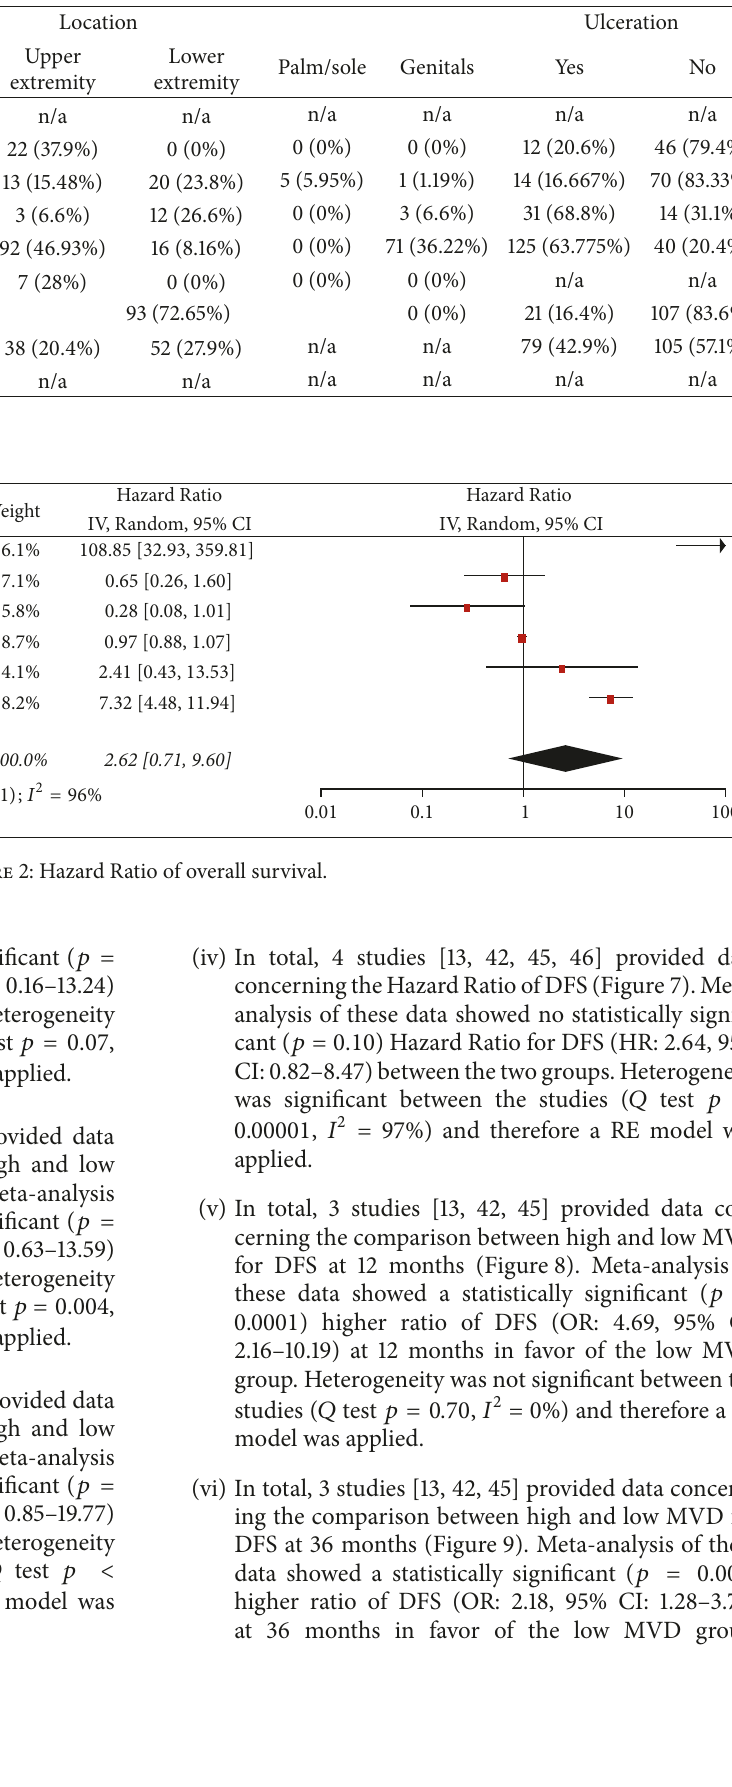
Table 3: Location and Ulceration.